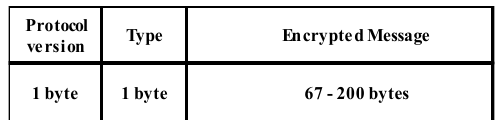
Figure 16. The format of an encrypted message for IEEE 1609.2.